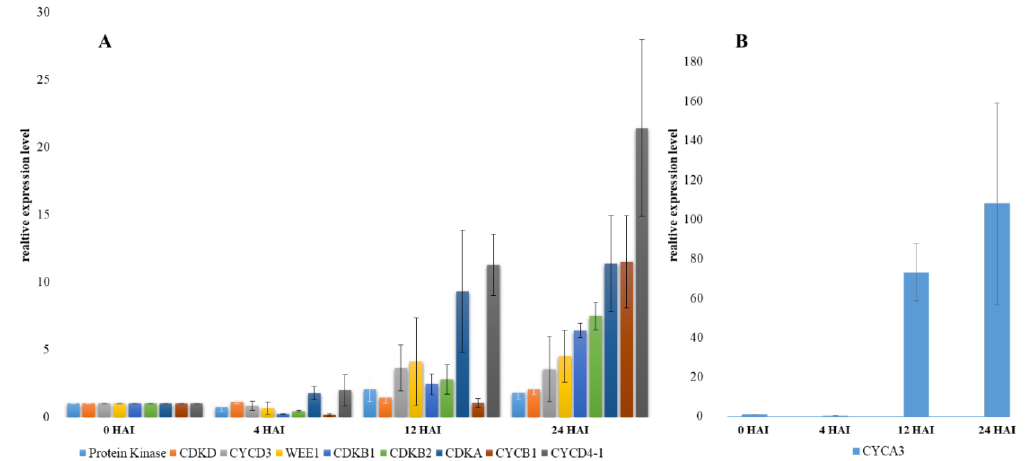
Figure 5. Expression of the CDKA , CDKB1 , CDKB2 , CDKD , CYCB1 , CYCD3 , CYCD4-1 , WEE1 , and protein kinase genes ( A ) and the CYCA3 gene ( B ) that were involved in the cell cycle activity in Brachypodium embryos at 0, 4, 12, and 24 HAI. The relative expression levels were normalised to an internal control (AK437296, gene encoding for ubiquitin) and calibrated to the control (the embryos from dried seeds). The data from RT-PCR (mean ± SD of three replicates) are given in arbitrary units.